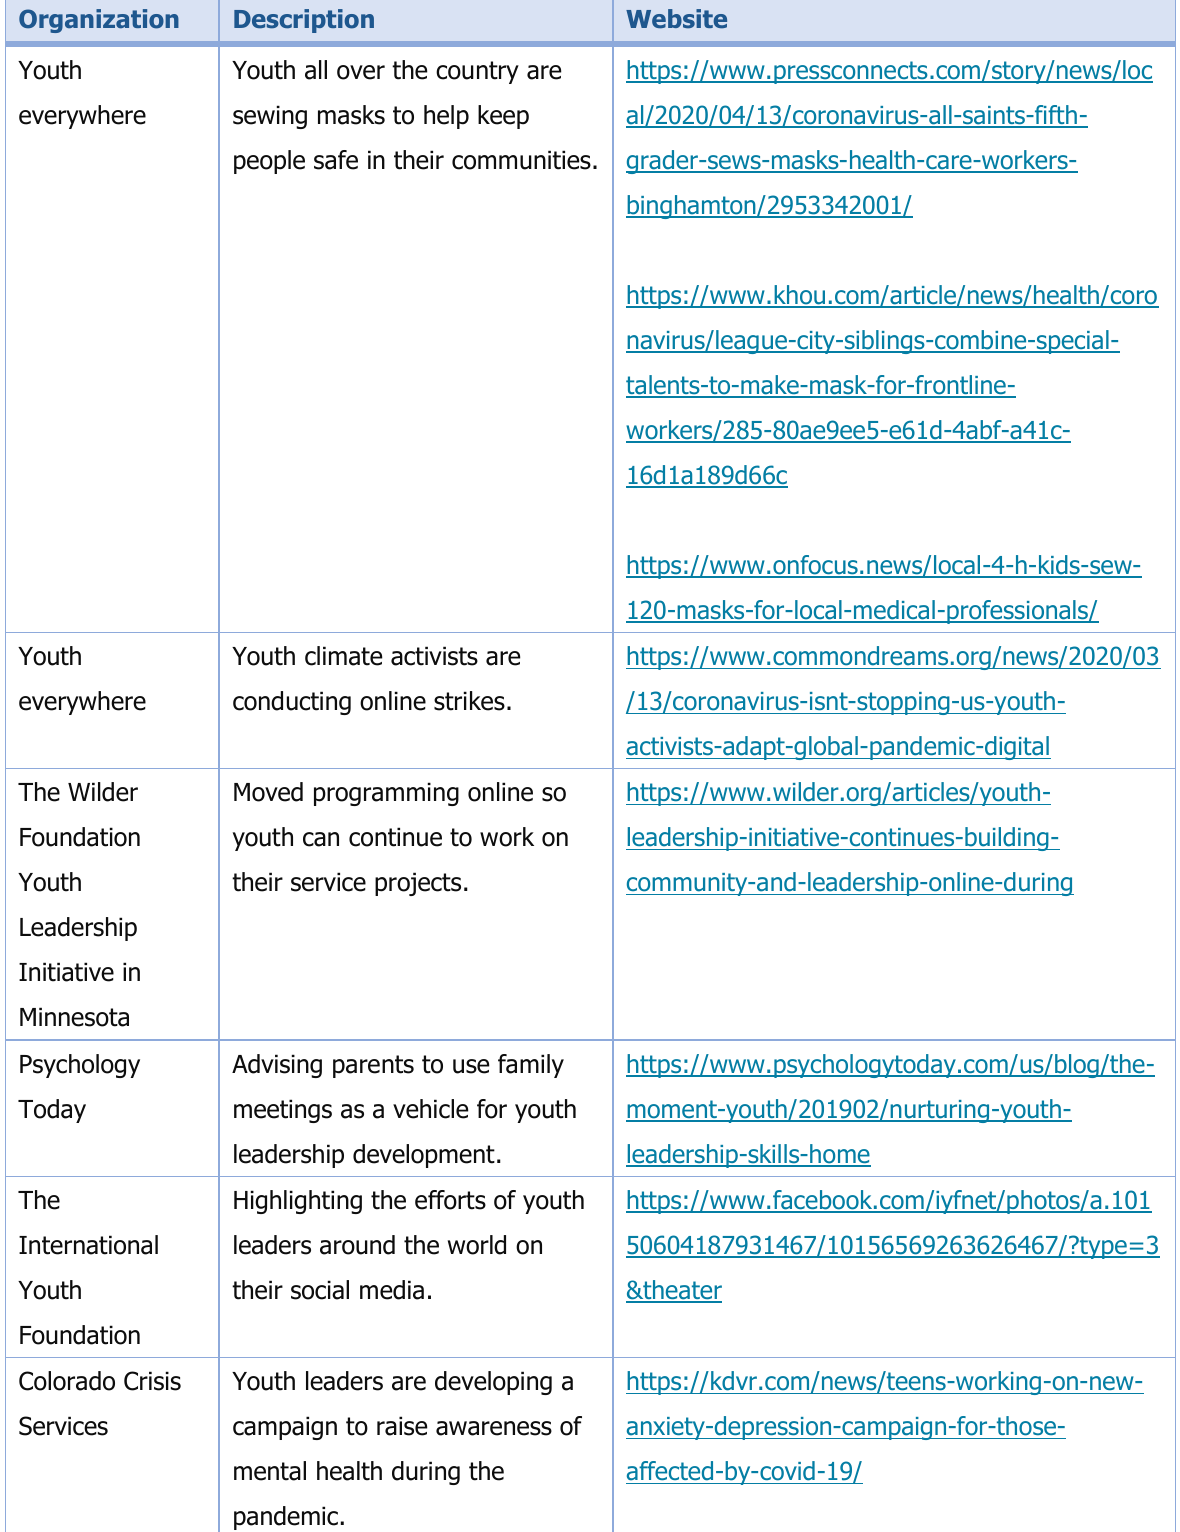
Table 3. Supporting Youth Leadership During the COVID-19 Pandemic